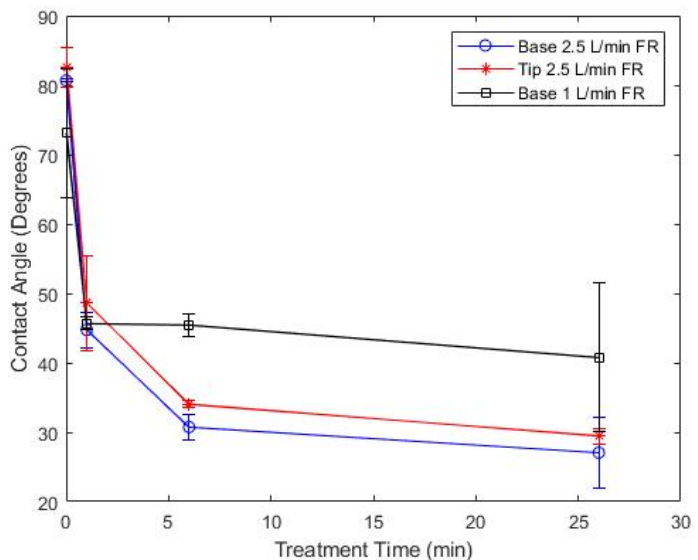
Figure 6. Contact angle measurements analyzed by ImageJ (Wayne Rasband. Image J . version 1.52a; National Institutes of Health: USA, 2018.).